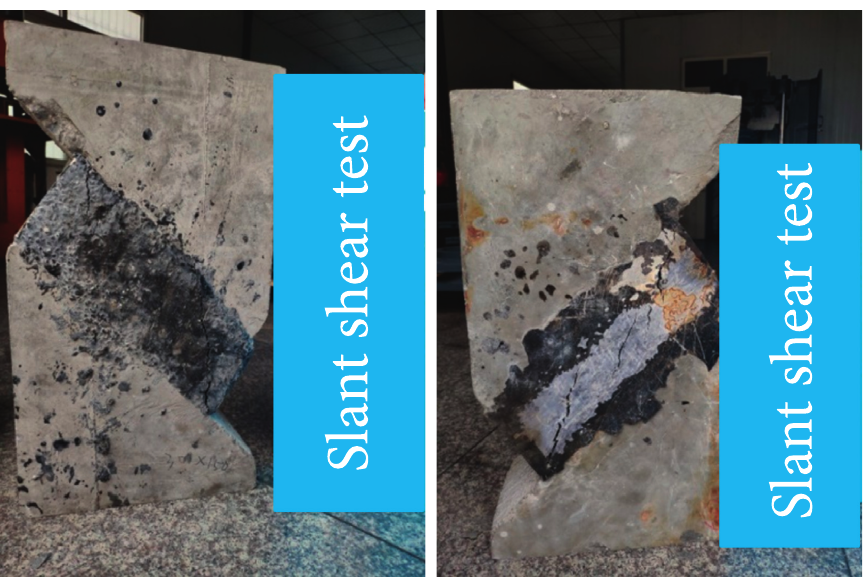
Figure 9: The failure mode of slant shear test specimen